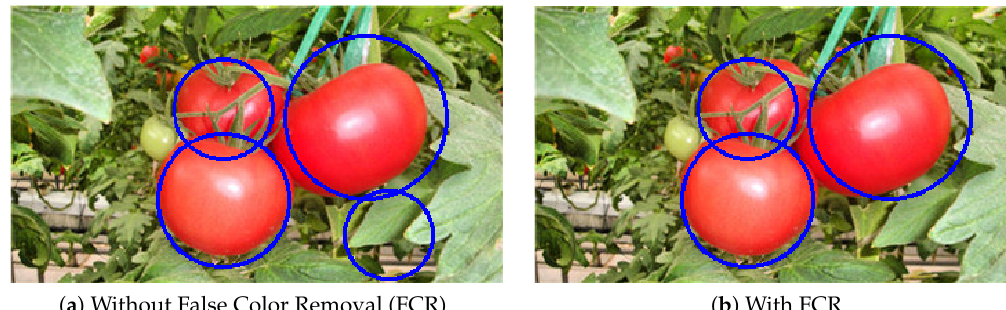
Figure 12. The results of the FCR: ( a ) without FCR and ( b ) with FCR.